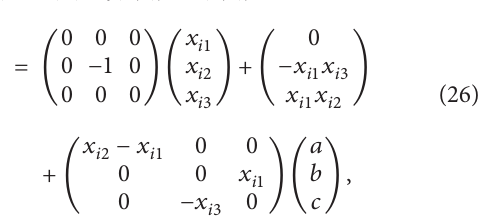
Figure 10: Synchronization error between the response and auxil- iary